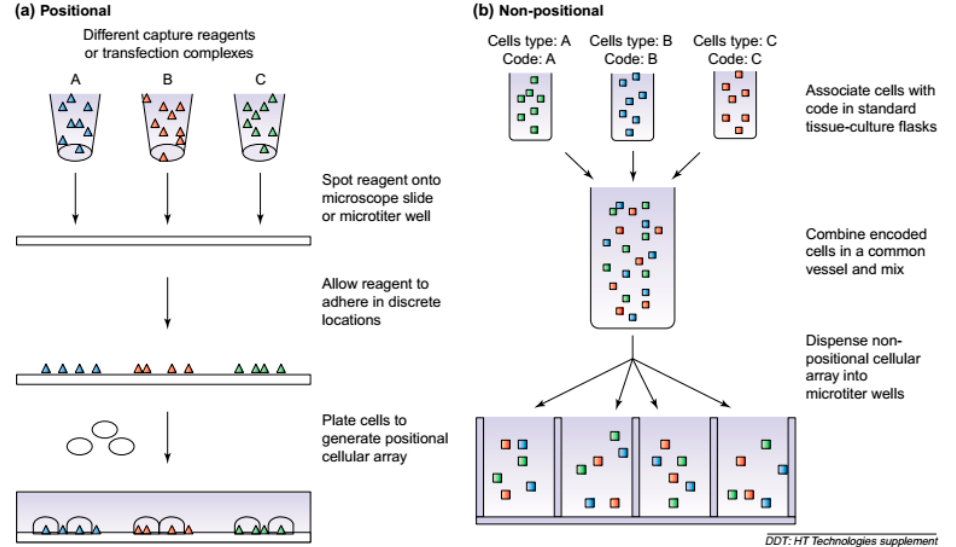
Figure 1. The generation of cellular arrays. ( a ) Positional cellular arrays are generated by localizing unique cell types to specific locations. For the Cellomics CellChip™ technology (http://www.cellomics.com), capturing agents are first spotted onto a substrate, and a population of cells is plated onto them. For reverse transfected cellular arrays, transfection reagents are first spotted and the cells plated onto them. ( b ) When generating non-positional cellular arrays, the different cell types are first associated with a unique code. These encoded cells are then mixed and aliquoted into a microtiter well for subsequent analysis. Reproduced from Beske and Goldbard, [16], with permission from Elsevier.